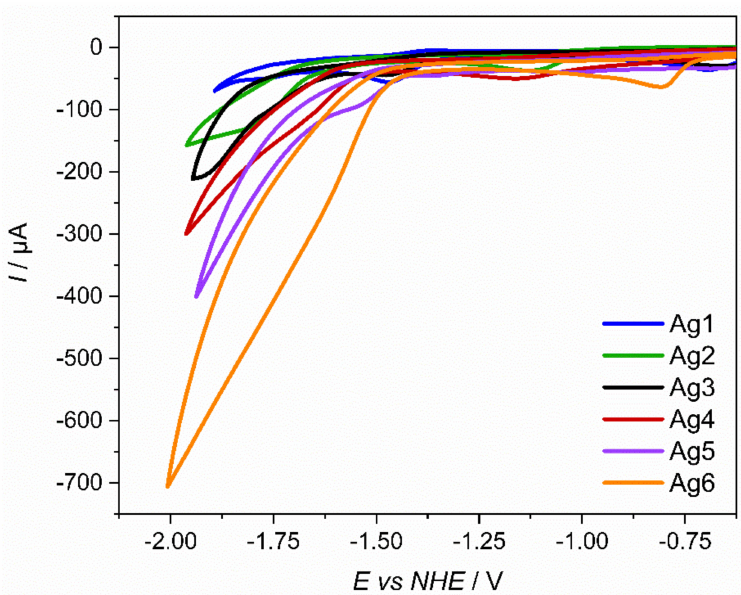
Figure 3. Homogeneous electrocatalysis of Ag(I) bis-BIAN complexes. Cathodic segment of cyclic voltammograms of 1 mM Ag1 - Ag6 (except for 0.5 mM Ag2 ) in CO 2 saturated ACN or DMF ( Ag1 ) with 2% H 2 O at a scan rate of 100 mV s − 1